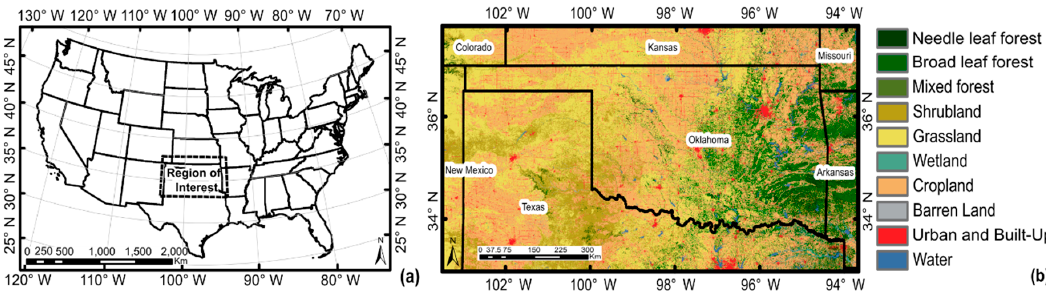
Figure 1. ( a ) Region of interest in the Midwestern USA, where soil moisture gap-filling methods were performed; ( b ) Land cover types over the region of interest (30 m), level 1 NALCMS classification [33].